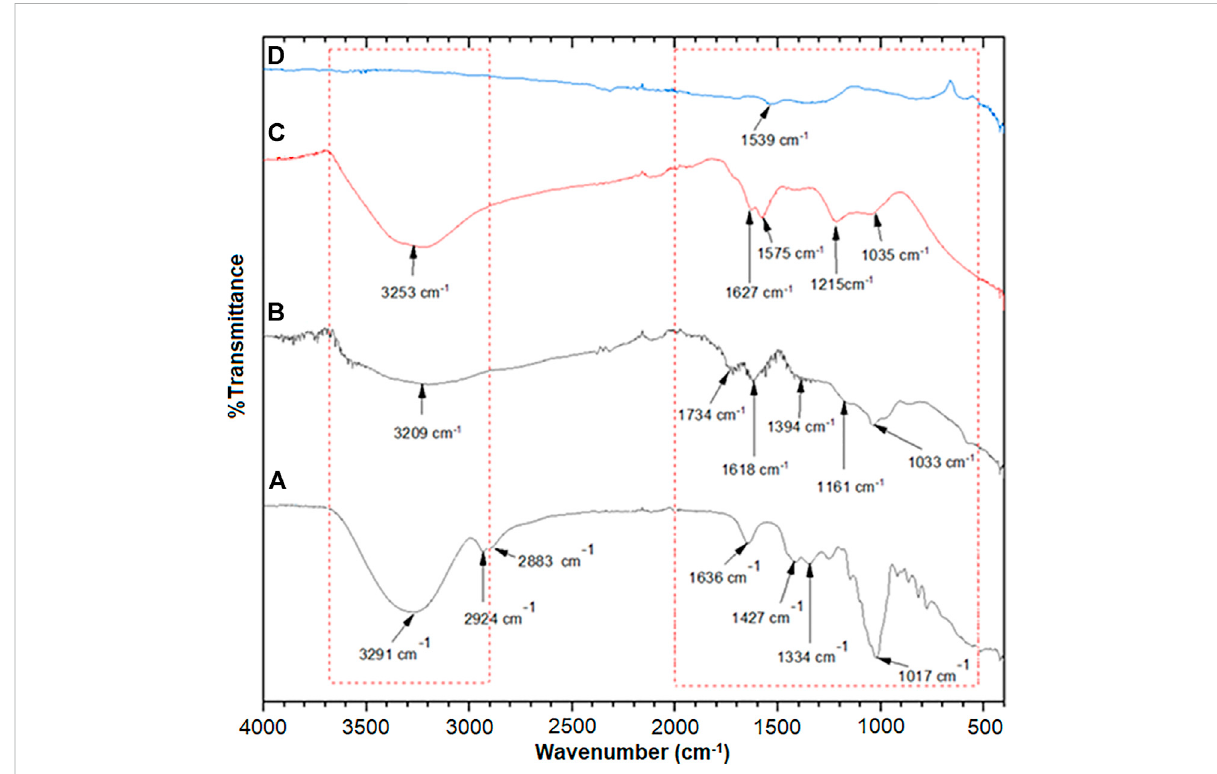
FIGURE 4 FTIR spectra of (A) honey, (B) GO, (C) RGO, and (D) H/Cu/RGO nanocomposite.